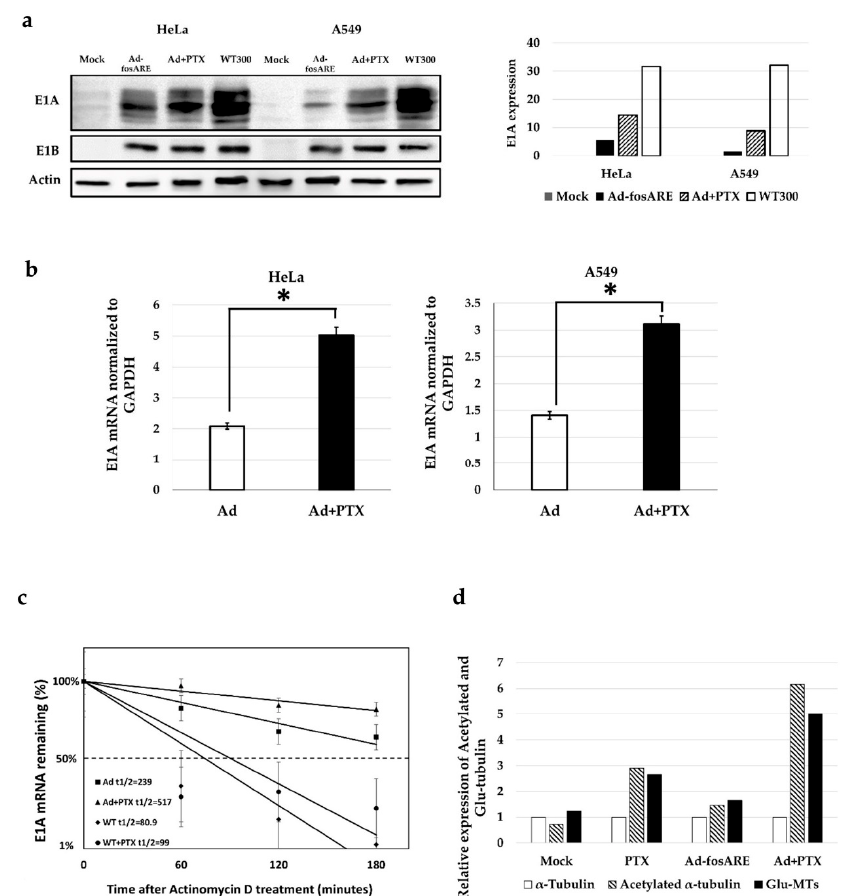
Figure 7. E ff ects of paclitaxel on Ad- fos ARE replication. ( a ) To check the viral protein synthesis, HeLa and A549 cells were treated in combination with Ad- fos ARE (MOI 10) and PTX (4 nM). E1A and E1B55kd were estimated by western blot analysis. Densitometric data of E1A expression (left) ( b ) With the same dose of treatment E1A mRNA was detected by quantitative real-time RT-PCR using GAPDH mRNA as a normalized control. ( c ) E1A mRNA stabilization in Ad- fos ARE infected cells. HeLa cells were infected with Ad- fos ARE and WT300 (MOI-10 ifu / cell) and combination with PTX. Transcriptions were inhibited by actinomycin D 5 µ l / mL for 60, 120, and 180 minutes. After the indicated periods, cells were harvested and extracted for total cellular RNA. mRNA levels are quantified by quantitative real-time RT-PCR experiments using GAPDH as a normalization control. Graphs depict the percentage of remaining E1A mRNA levels with GAPDH mRNA and compared with the standards of normalized mRNA species measured immediately after the addition of actinomycin D and which were set as 100%. The half-lives of the mRNAs (min) are indicated as t½. ( d ) To determine post-translationally modified tubulin, HeLa cells were treated with either Ad- fos ARE, PTX or a combination of both. The expression of acetylated and Glu-MTs was quantified by densitometry and the values were normalized to non-infected conditions. Data are shown as the mean ± standard deviation of three independent experiments (* indicates p < 0.05).